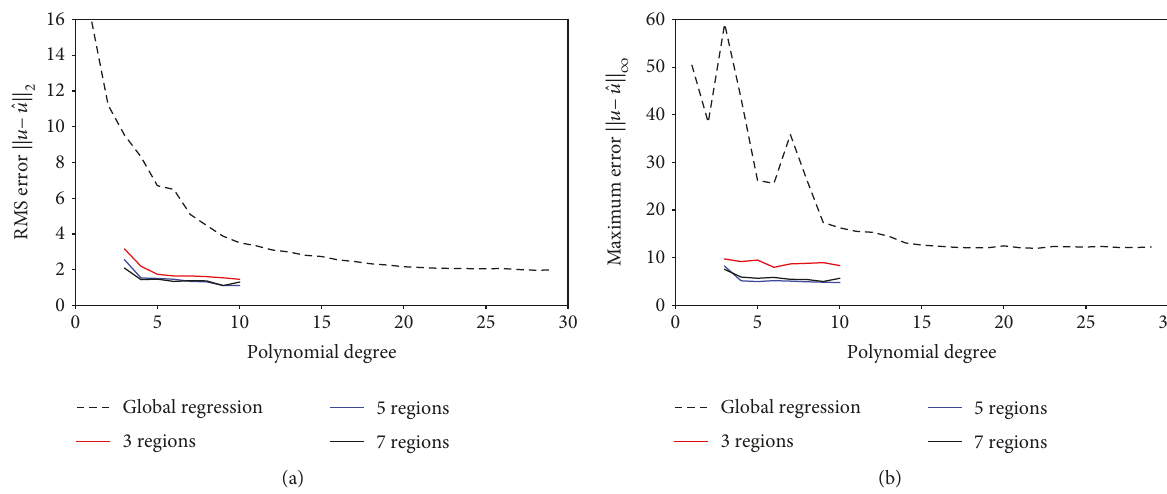
Figure 2: Polynomial approximation accuracy in L 2 (RMS) norm (a) and L ∞ (maximum) norm (b)